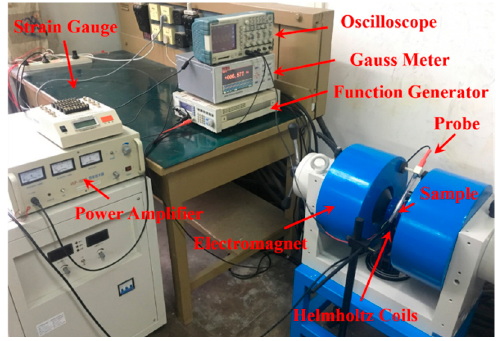
Figure 5. The experimental setup for ME measurement system.